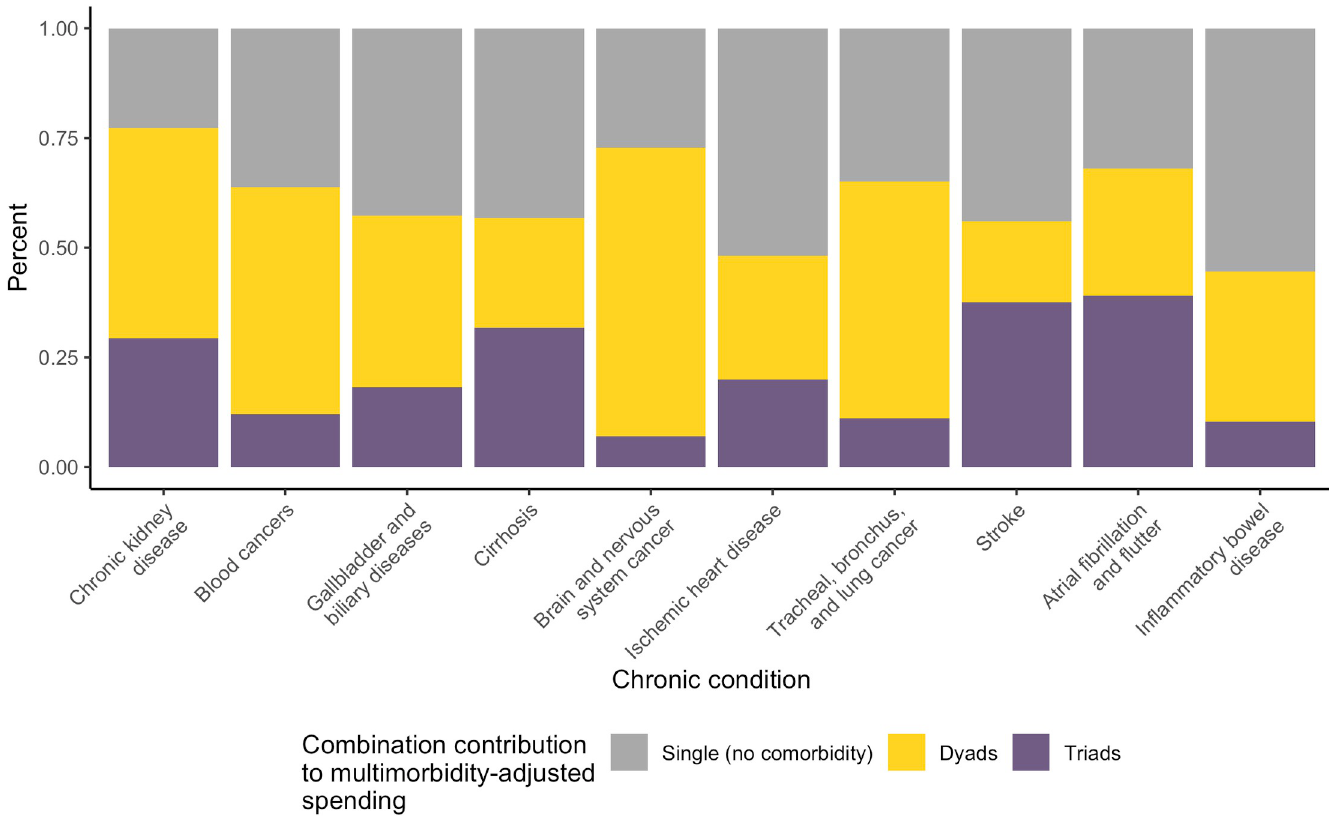
Fig 2. Decomposition of multimorbidity-adjusted spending by the type of combination (single, dyads, triads) for chronic conditions with the top 10 highest spending per treated case.